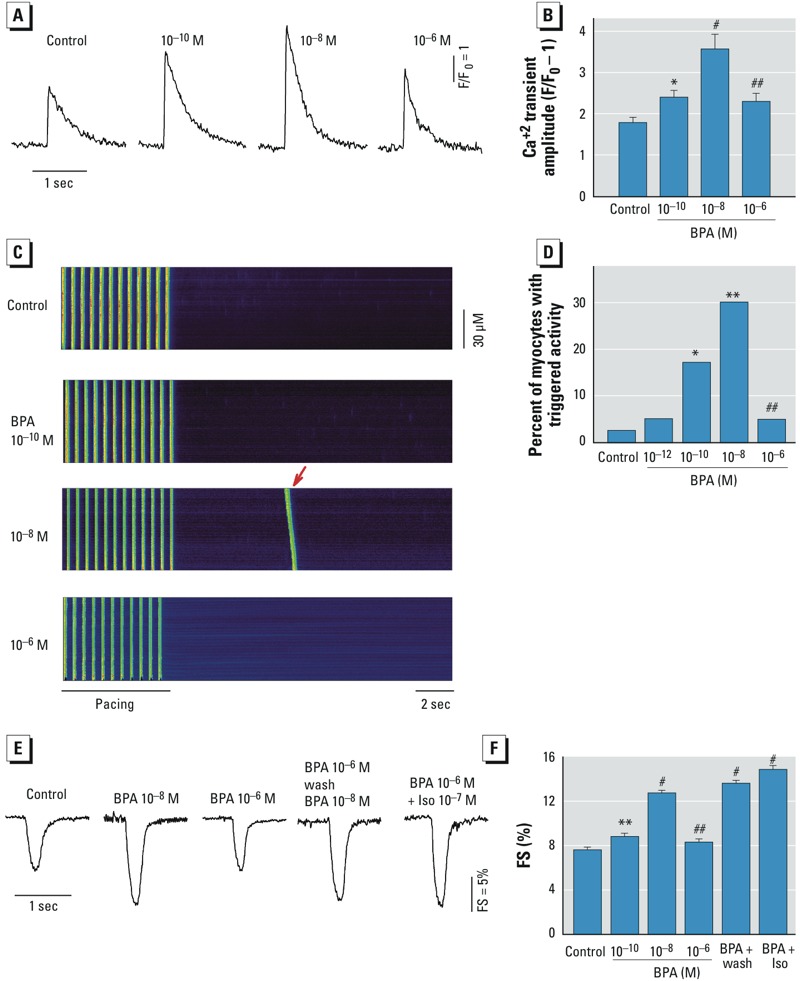
Nonmonotonic dose responses of BPA (10–10, 10–8,or 10–6 M) in female rat ventricular myocytes. F/F0, fluorescence intensity ratio. (A) Representative Ca2+ transient traces after acute exposure to indicated concentrations of BPA or control solution. (B) Dose–response of the effects of BPA on myocyte Ca2+ transient amplitude (n = 23, 18, 17, and 17 myocytes for control and 10–10, 10–8, and 10–6 M BPA, respectively). (C) Representative confocal images of Ca2+ transients in female rat myocytes elicited by repeated pacing after acute exposure to BPA or the control. Arrows indicate spontaneous Ca2+ after-transients (i.e., triggered activity) following pacing. (D) Dose–response of the effects of BPA on the percentage of myocytes with triggered activity (n = 40, 40, 41, 43, and 41 myocytes for control and 10–10, 10–8, and 10–6 M BPA, respectively). (E) Representative contraction traces of myocytes exposed control, BPA, or BPA plus isoproterenol (Iso) as indicated for 2–7 min. (F) Dose–response effects of BPA on average fractional shortening (FS) (n = 20, 19, 20, 20, 20, and 20 myocytes for control; 10–10, 10–8, and 10–6 M BPA; 10–6 M BPA pretreatment + wash; and 10–6 M BPA + Iso, respectively). Values shown are mean ± SE.
*p < 0.05, **p < 0.01, and #p < 0.001, compared with control by one-way ANOVA (B,F) or chi-square test (D). ##p < 0.01, compared with 10–8 M BPA by unpaired t-test or chi-square test.